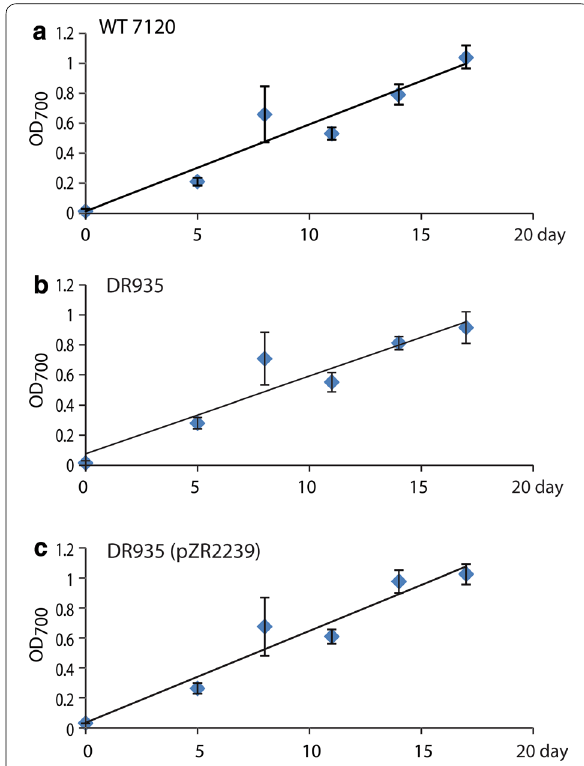
Fig. 5 Growth phenotypic analysis from wildtype, DR935, and DR935(pZR2239) cultures grown in BG11 medium. Growth curve of wildtype Anabaena 7120 ( a ), DR935 ( b ), and c